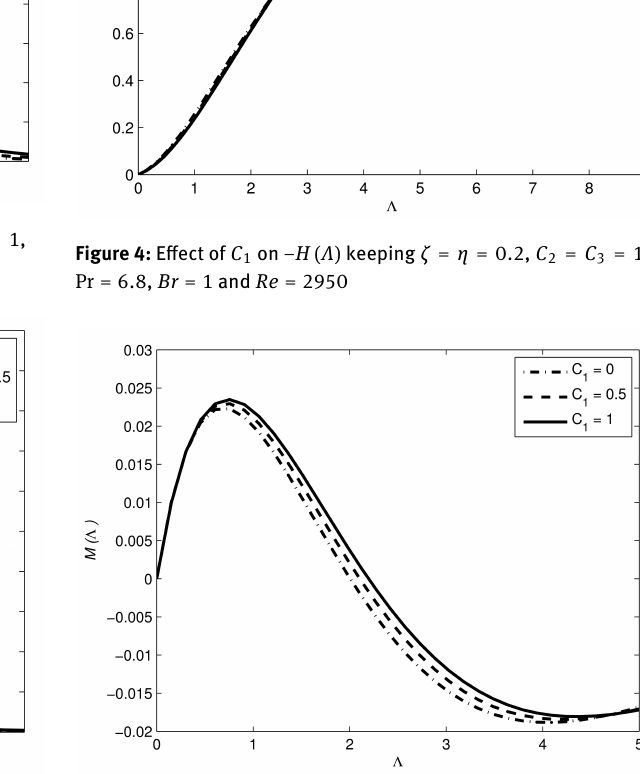
Figure 5: Effect of C 1 on M ( Λ ) keeping ζ = η = 0.2 , C 2 = C 3 = 1 , Pr = 6.8 , Br = 1 and Re =